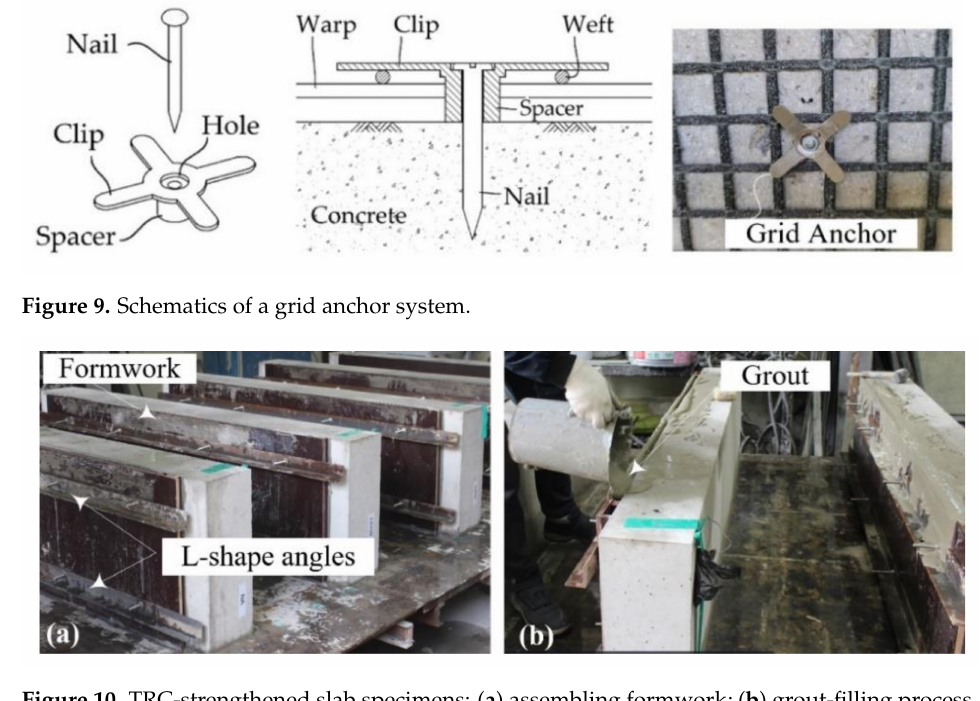
Figure 10. TRC-strengthened slab specimens: ( a ) assembling formwork; ( b ) grout-filling